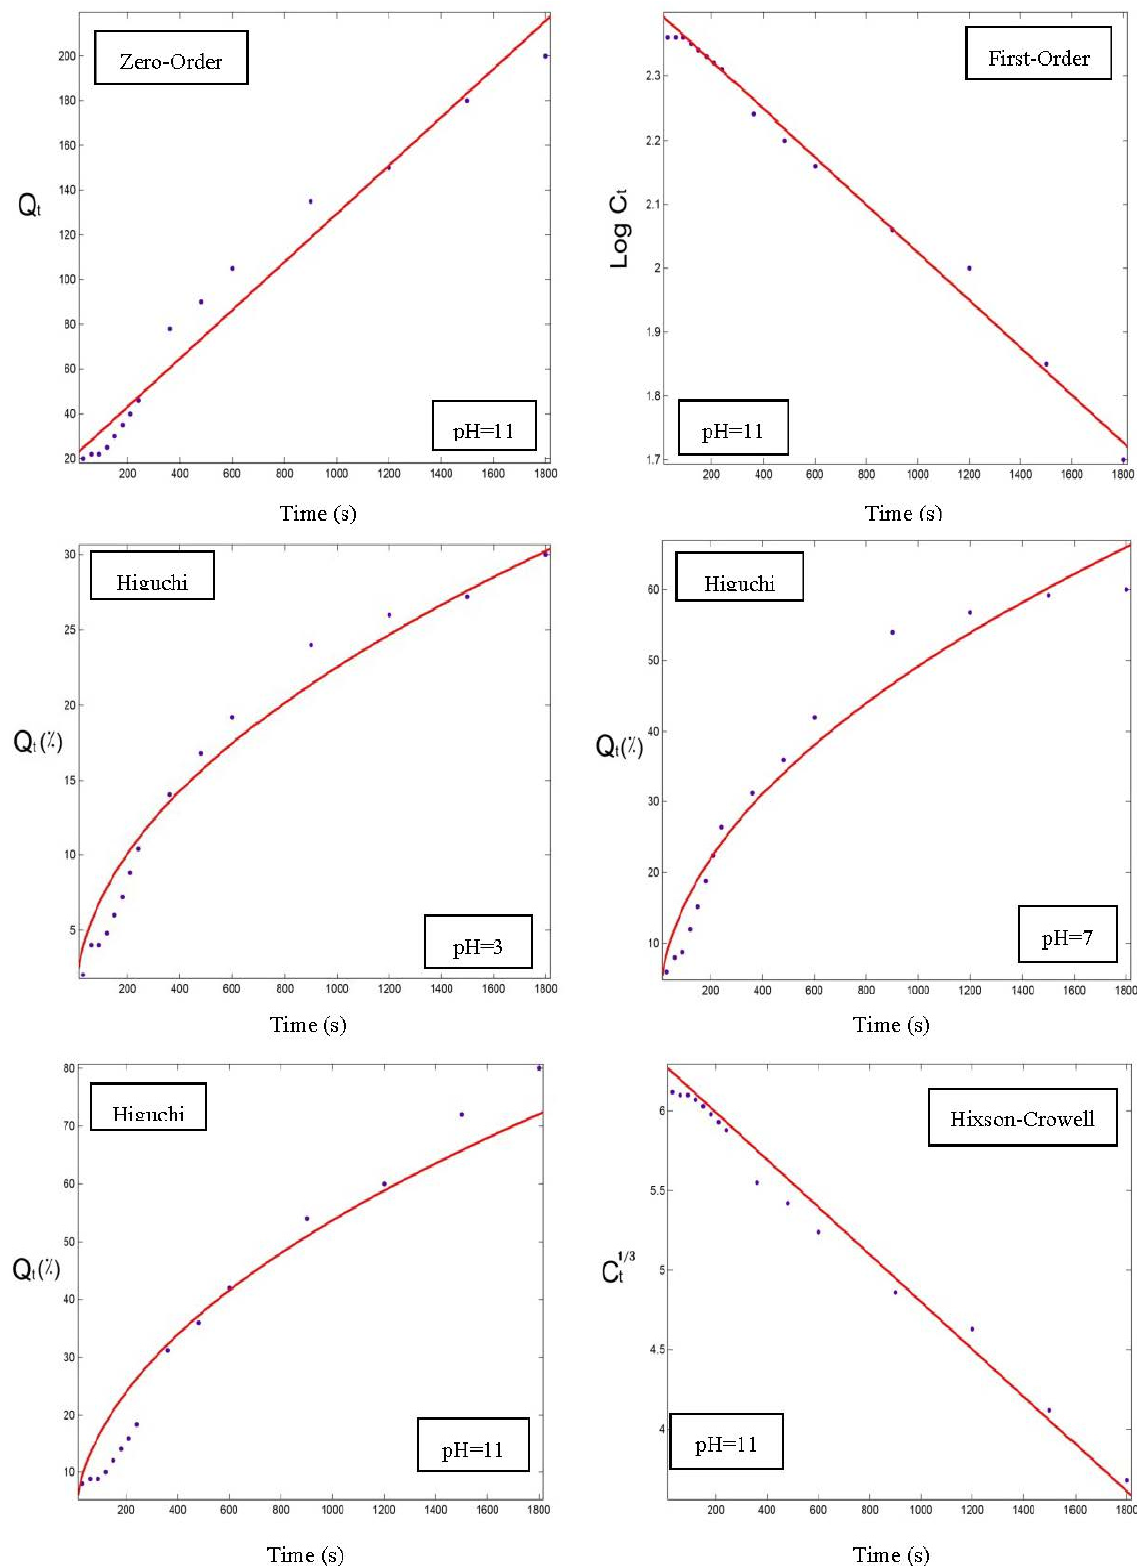
Figure 6. Release profiles (dots) and regression modeling (red lines) of orange peel oil dissolution from nano-delivery systems of pectin–whey protein powder particles (NC3) at 30 °C and different pH values.